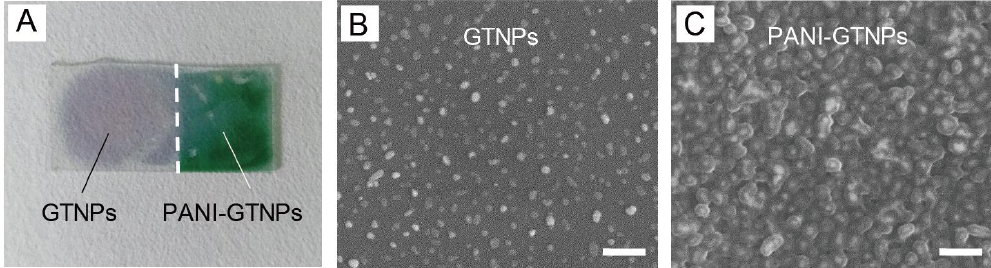
Figure 1. ( A ) Optical image of gold nanoplates (GNPs) and polyaniline (PANI)-GNPs on glass; scanning electron microscope (SEM) images of ( B ) GNPs; and ( C ) PANI-GNPs on glass. The scale bars in (B) and (C) are 400 nm.